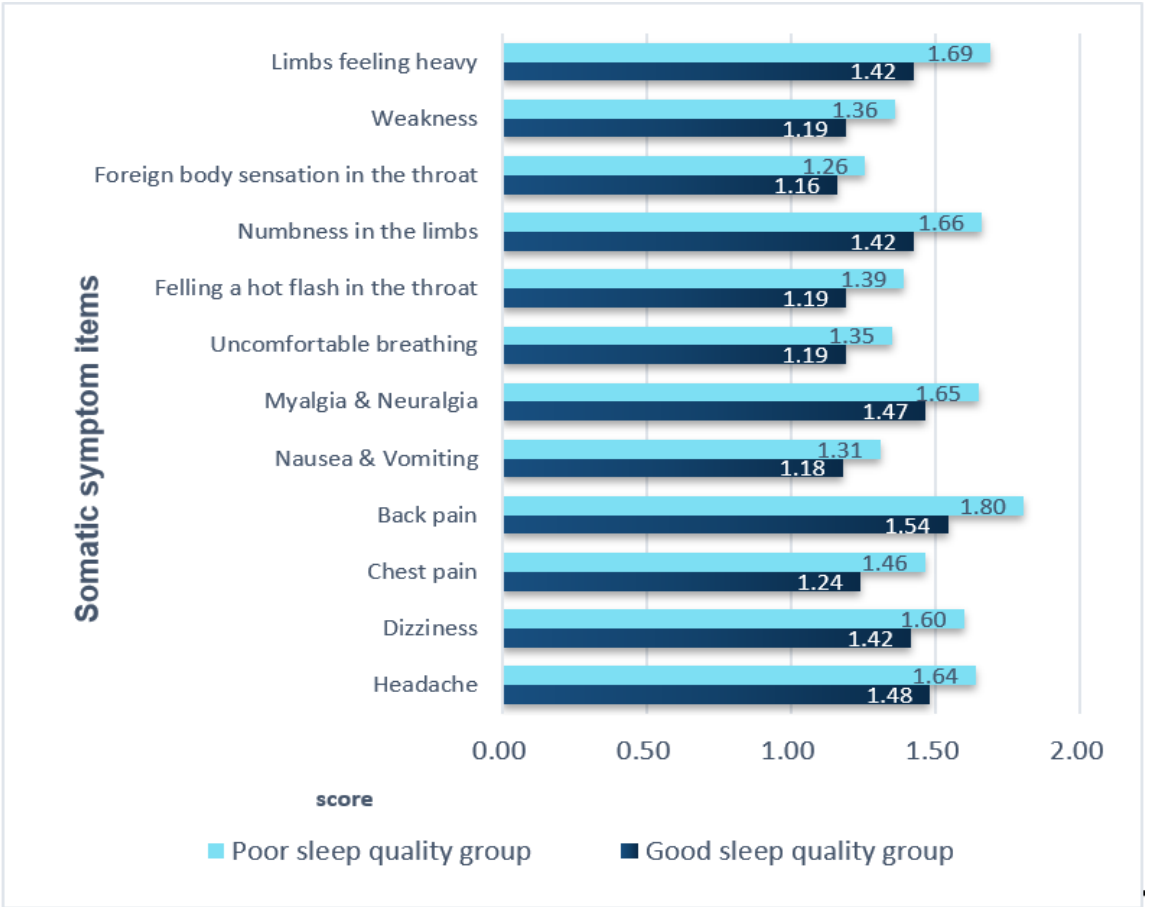
Table 4. Predictors of sleep quality in middle-aged women with CVD risk factors (N = 204). Variables.